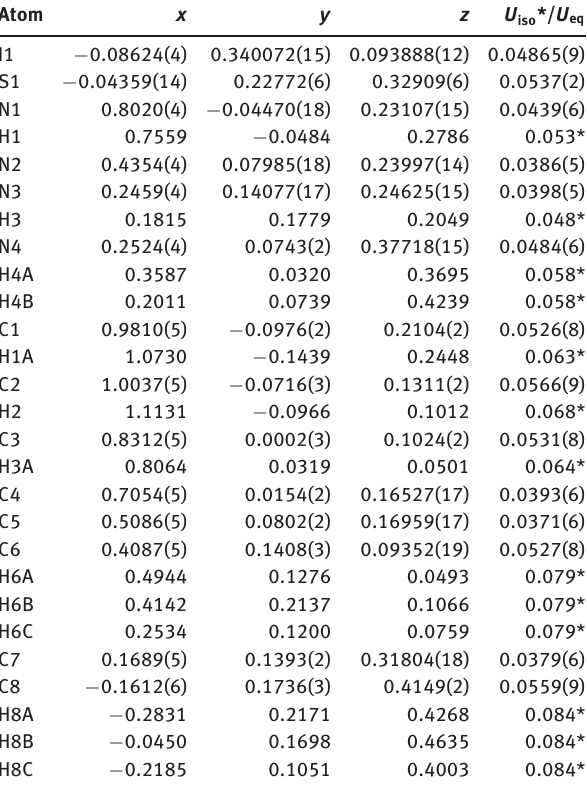
Table 2: Fractional atomic coordinates and isotropic or equivalent isotropic displacement parameters (Å 2 ).